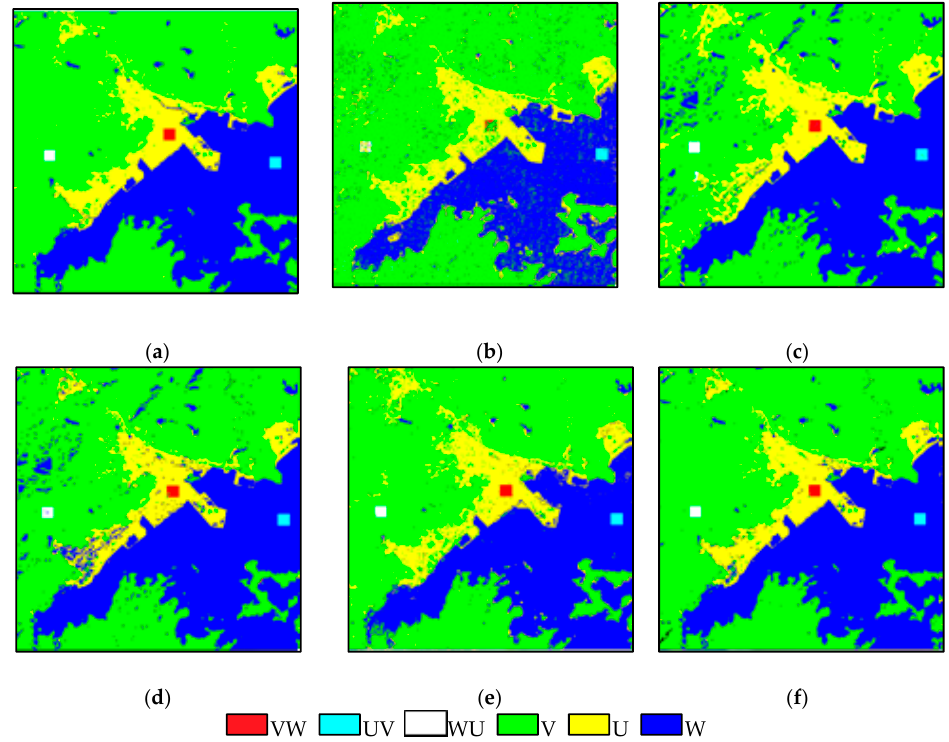
Figure 6. The change detection results of the simulated data: ( a ) reference image, ( b ) CD_PC, ( c ) CD_SU, ( d ) CD_SSU, ( e ) CD_SDSU and ( f ) CD_SDSUVE.